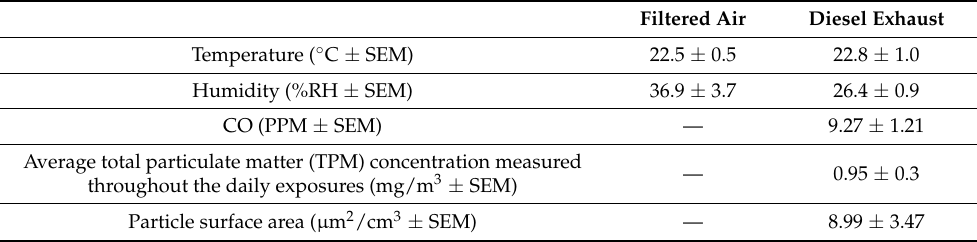
Table 2. Diesel exhaust exposure characterization data measured inside the exposure chambers in the breathing zone of the animals.